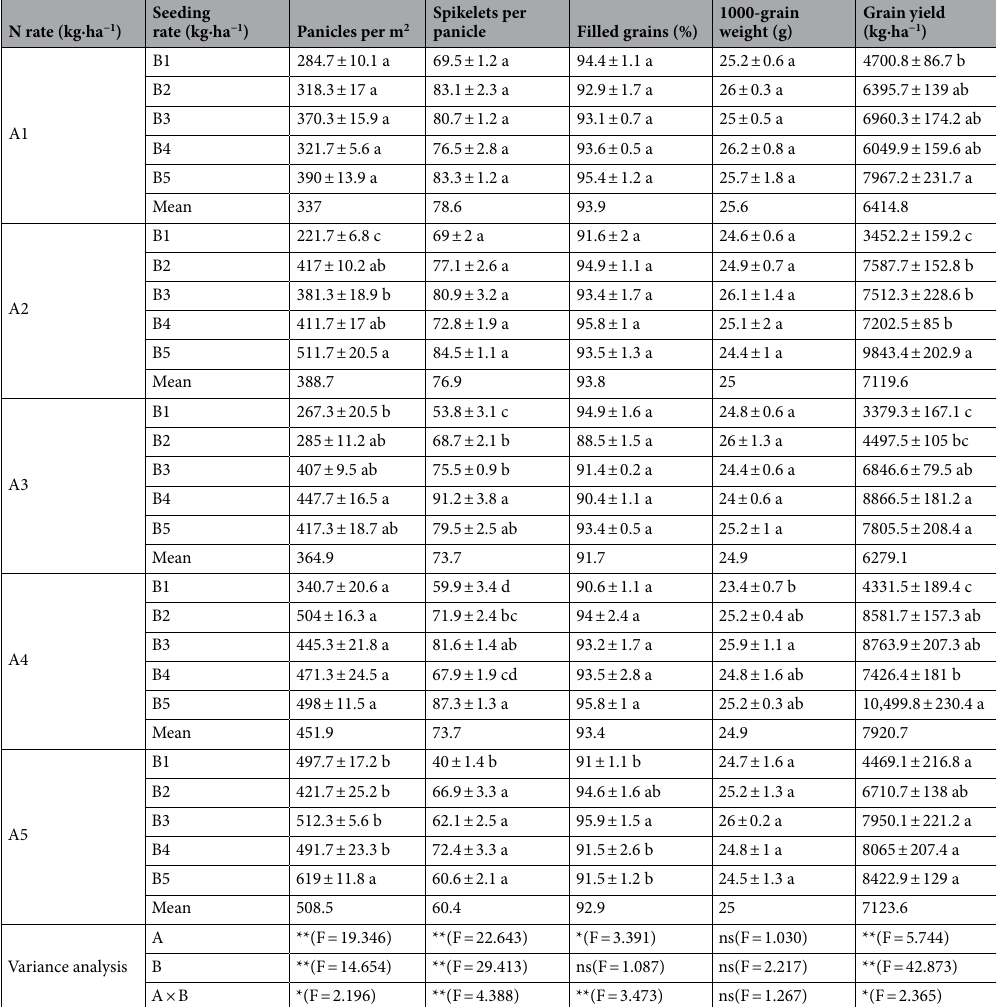
Table 1. Effects of interaction between seeding rate and nitrogen rate on yield and yield components of rice under dry cultivation. A: Seeding rate, B: N rate. A1: 60 kg·ha −1 , A2: 105 kg·ha −1 , A3: 150 kg·ha −1 , A4: 195 kg·ha −1 , and A5: 240 kg·ha −1 ; B1: 0 kg·ha −1 , B2: 70 kg·ha −1 , B3: 140 kg·ha −1 , B4: 210 kg·ha −1 , and B5: 280 kg·ha −1 . The values represent the mean ± SD of three replicates. Different letters with the same sowing amount indicate a significant difference at P < 0.05. * and ** indicate that the yield components are significantly influenced by the N rate, seeding rate, and their interactions at 0.05 and 0.01 levels, respectively, and ns indicates “not significant”. This applies to all following